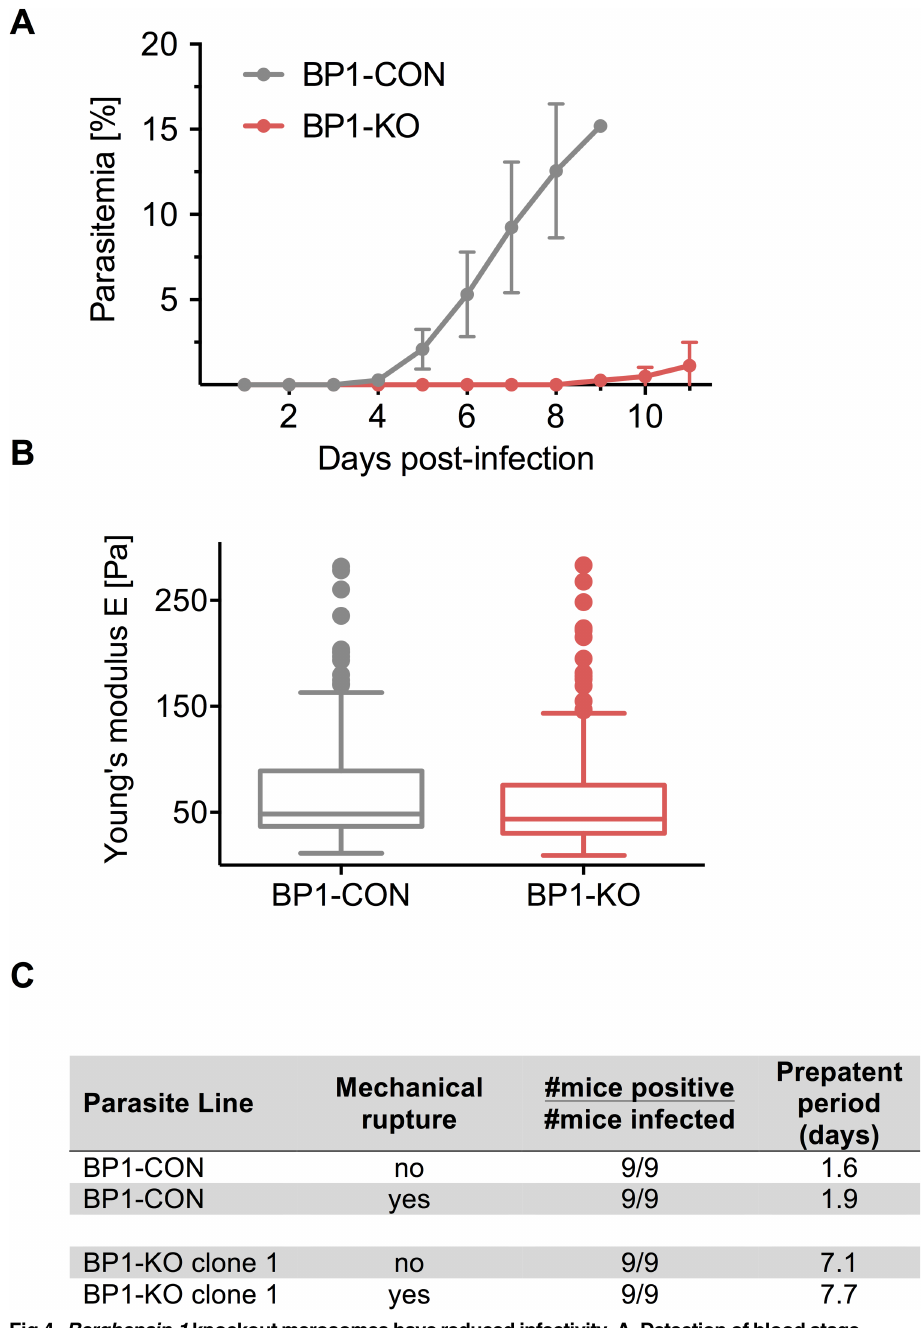
Fig 4. Berghepain-1 knockout merosomes havereducedinfectivity.A. Detection of blood stage parasitemia following injection of merosomes. Five merosomes of BP1-KOor BP1-CON parasiteswere injectedi.v. permouseandparasitemia wasmonitoreddailyfor 11 days.Results from tworepresentative experiments areshownandthe averagedailyparasitemia ± SDof 5 miceinfectedwithBP1-CONand6 mice infectedwithBP1-KOclone2 areplotted. B. Atomicforcemicroscopy of the merosomemembrane. Merosomes of BP1-CONandBP1-KOparasiteswerefixedandsubjectto AFM to measureYoung’smodulus(E). Cellelasticity wasmeasured on onepointof eachcelladheredto a poly-L-lysine-coatedglassslidewith5 force- distancecurvespercell. Datais displayedina Tukeyboxandwhiskerplot,witha horizontal linerepresenting the medianandindividually plottedoutliervalues.Shownarepooledvaluesof sevenindependent experiments, four performedwithBP1-KOclone1 andthreewithBP1-KOclone2, correspondingto approximately 195cellsfor eachclone. C. Detectionof blood stageparasitemia following injection of unruptured or mechanically